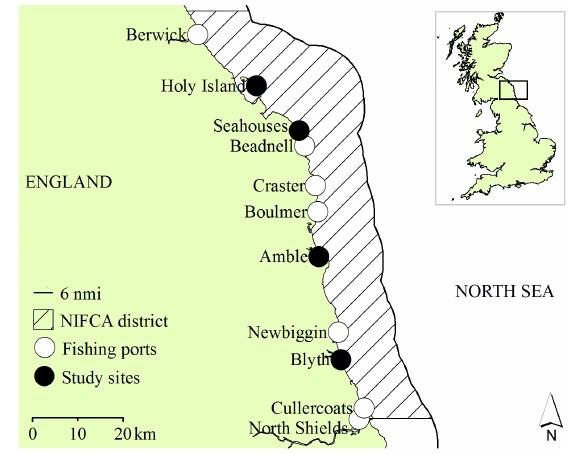
Fig. 1 . Map of the Northumberland Inshore Fisheries and Conservation Authority (NIFCA) district and local shellfish